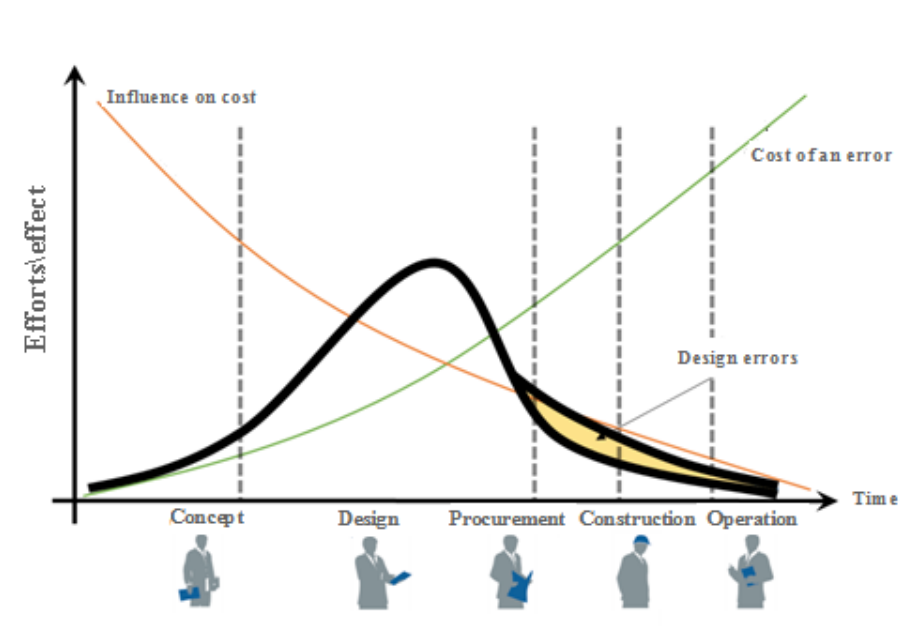
Fig. 3. Traditional design cost spread over a real estate asset lifecycle (developed by the authors, based on the data provided by DB H&US).